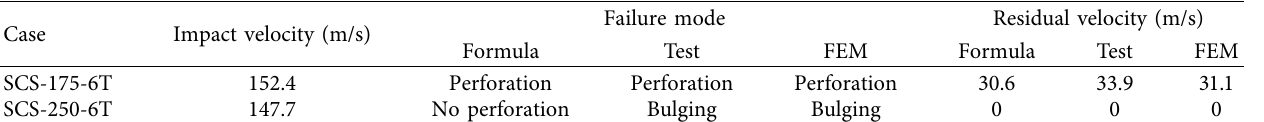
Table 2: Results